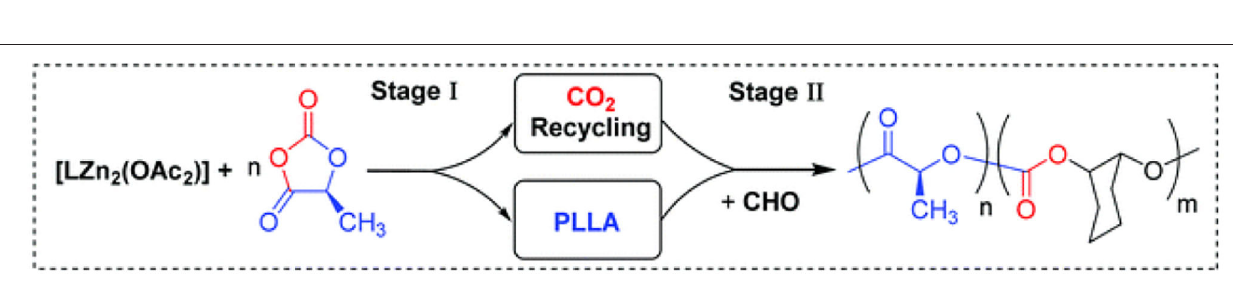
FIGURE 4 | Proposed polymerization pathway whereby the di-zinc catalyst bridges two catalytic cycles: LLA-OCA ROP and CO 2 /CHO ROCOP. LLA-OCA, L -lactide- O -carboxyanhydride; ROP, ring-opening polymerization; ROCOP, ring-opening copolymerization. Adapted with permission from Raman et al. (2019). Copyright 2019 The Royal Society of